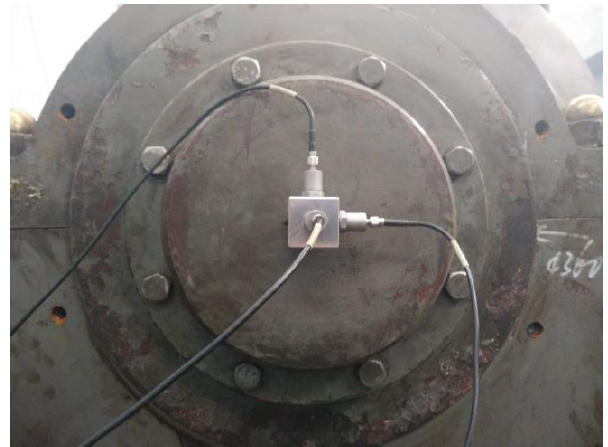
Figure 10. Picture of the mounted vibration acceleration sensor.